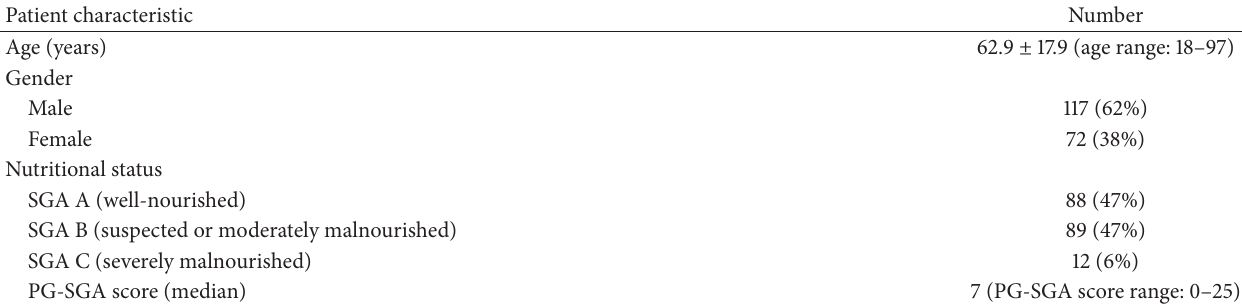
Table 1: Demographic variables of 2012 point prevalence study population ( 𝑛 = 189